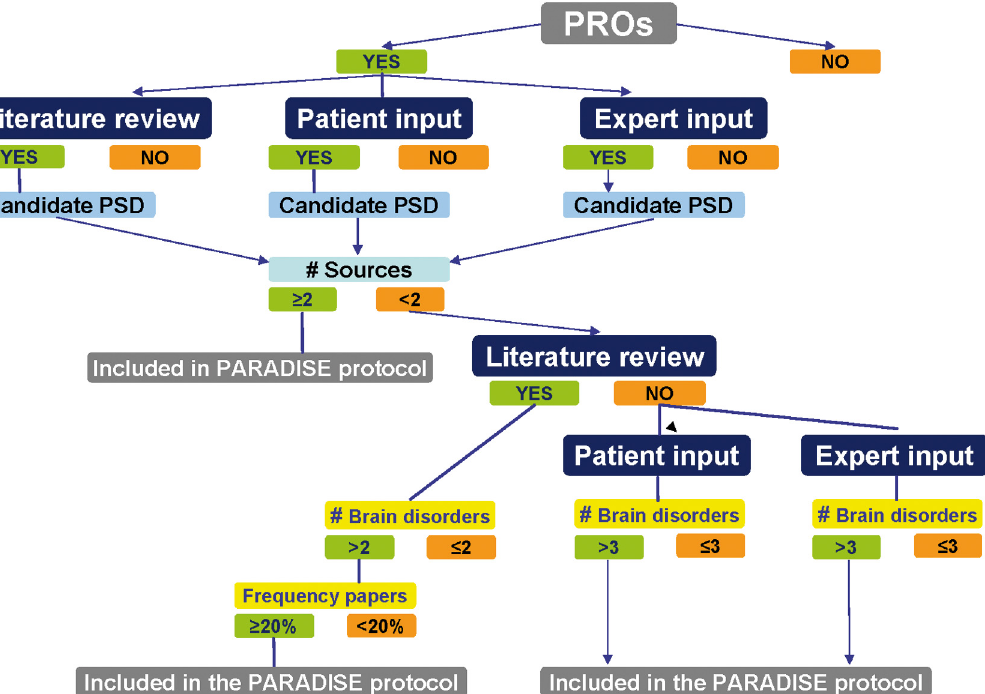
Fig 2. Decision tree used for selecting relevant psychosocial difficulties across brain disorders. The starting point of the decision tree was the list of psychosocial difficulties (PSD) addressed in the 27 patient reported outcome (PRO) or outcome instruments identified in the literature reviews. If a PSD was addressed in at least one of the PROs or outcome instruments and had also been identified in at least two of the three sources of information (literature reviews, qualitative study and clinical input), this PSD was selected for inclusion into the data collection protocol. If a PSD had only been included in one of the sources of information, then if it had been identified in the literature reviews of at least two brain disorders and in those in > 20% of the studies included in the reviews, then the PSD was also included in the PARADISE protocol. If not, then if it had been included in the patient input studies for more than three brain disorders, or in the clinical input for more than three brain disorders, in both cases it was included in the protocol.